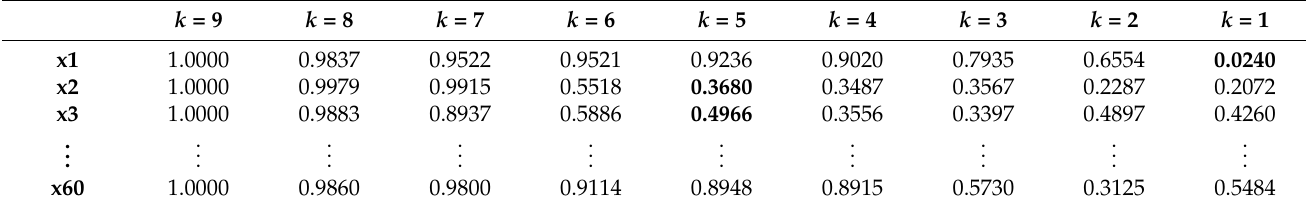
Figure 2. The curves of selected original data and the augmented data. ( a ) The curves of 139 original data and some of the augmented data (x1); ( b ) the curves of 139 original data and some of the augmented data (x3). Table 4. The value of cosine similarity of the paper grade